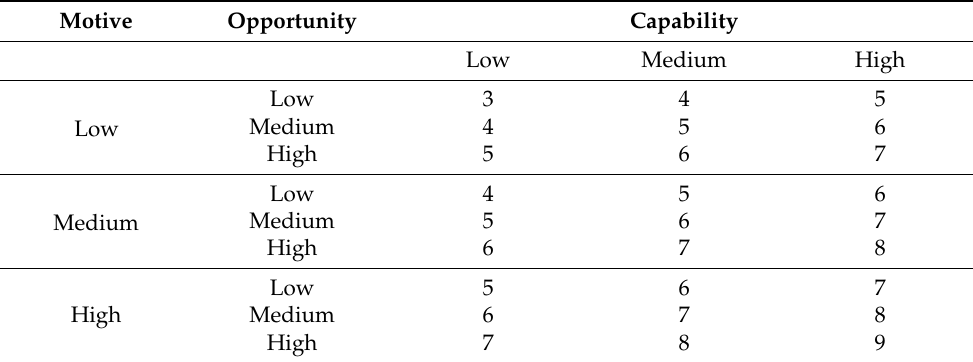
Table 5. Motive, Opportunity and